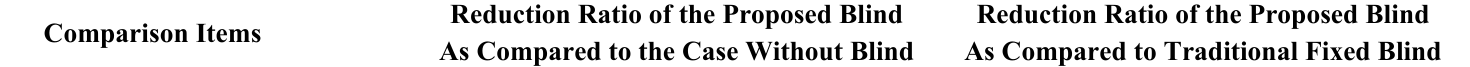
Table 3. Thermal comfort alleviating and sensible cooling energy saving potential of blinds in Taipei and Kaohsiung for SW oriented